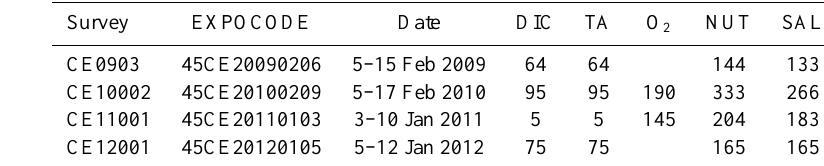
Table 2 Details of surveys with number of chemistry samples taken on each. Table 2. Details of surveys with number of chemistry samples taken on each. Survey EXPOCODE